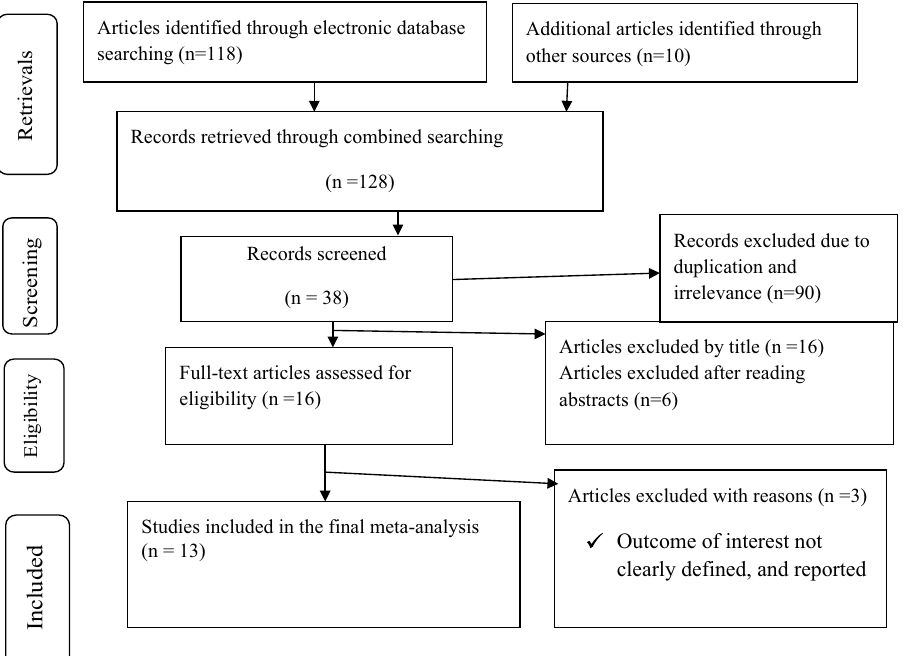
Figure 1. PRISMA flow diagram showing search results for the inclusion of studies focusing on first line ART failure among Children in Ethiopia,